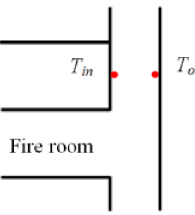
Fig. 6. Instantaneous temperature curves of T in and T out with d = 1.4